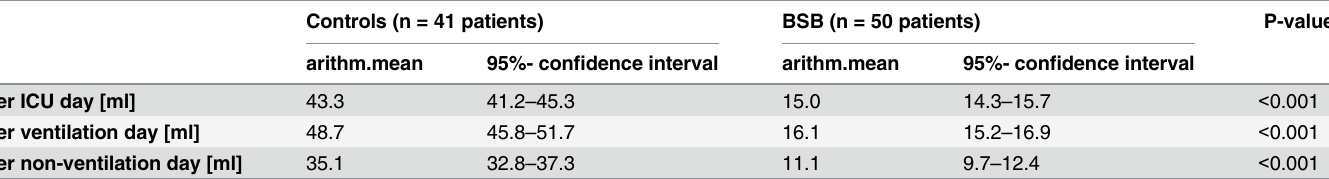
Table 2. Average blood loss per Patient [ml] in controls compared to the BSB group per ICU day and during ventilation and non-ventilation days.